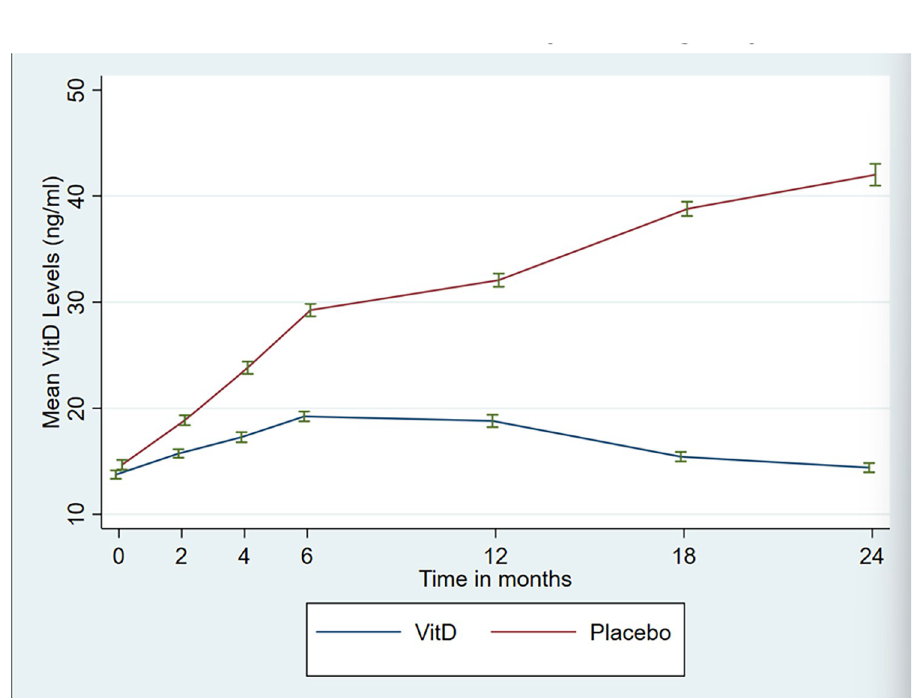
Fig 5. Mean Vit D Levels in both the control and placebo groups. Shows the mean Vitamin D Levels in both Vitamin D and placebo groups. There was significant increase in the Mean Vitamin D levels in the Vitamin D group with time. Error Bars represent 95% C.I.